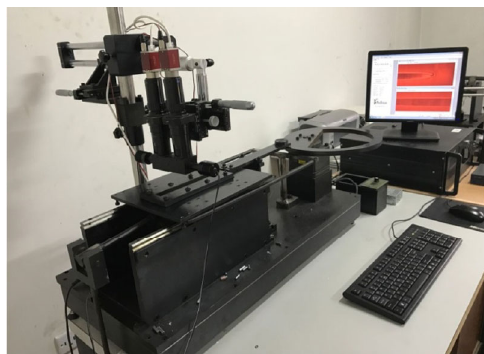
Fig. 3 Finite-line contact EHD